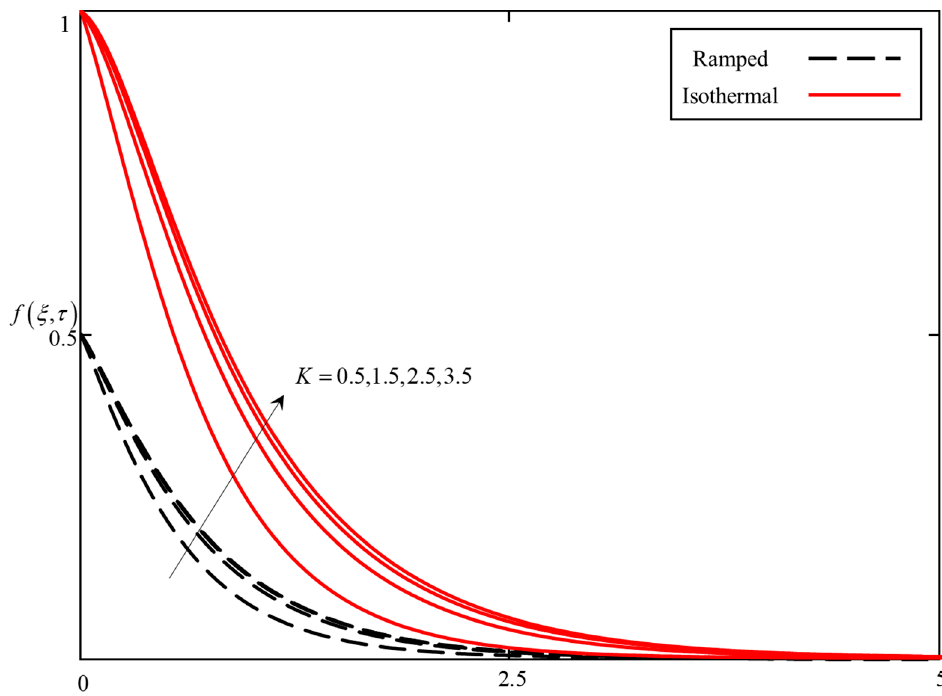
Figure 13. Consequence of K on the velocity field, when α = 0.5, β = 0.5, φ = 0.04, λ 1 = 0.5, λ 2 = 0.5, M = 0.5, Pr = 21, and Gr =